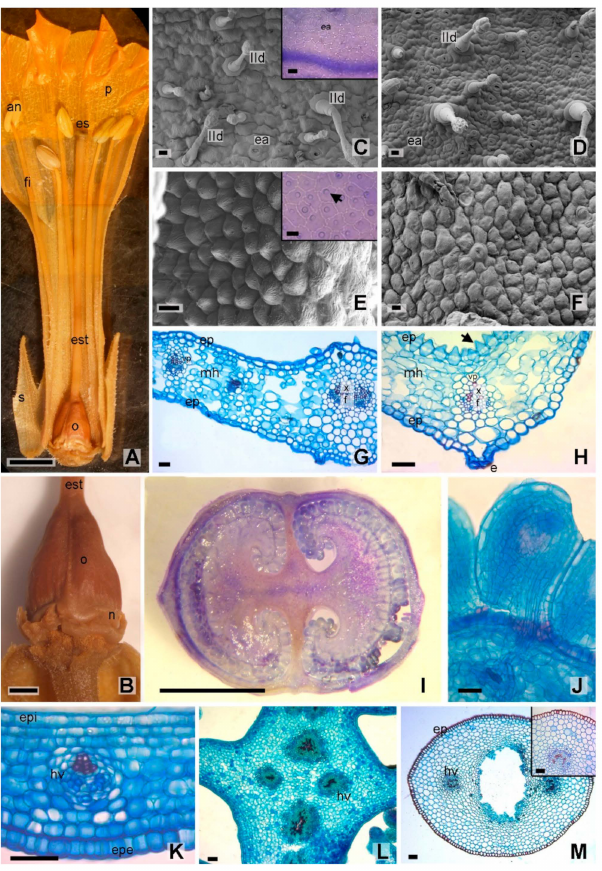
Figure 2. Nicotiana tabacum var. Virginia. Morphology and anatomy of the flower. ( A ) General appearance. ( B ) Detail of ovary and nectary. ( C – H ) Perianth. ( C – F ) Superficial view of epidermis in MEB. ( C ) Sepal, upper epidermis, insert detail in light microscope. ( D ) Sepal, lower epidermis. ( E ) Petal lobe, papillated upper epidermis, inset detail in light microscope. ( F ) Petal, lower epidermis. ( G ) Transverse section of sepal. ( H ) Transverse section of petal. ( I – M ) Gynoecium ( I – L ) Cross section of ovary. ( I ) General appearance. ( J ) Anatropous ovule. ( K ) Ovary wall. ( L ) Ovary central